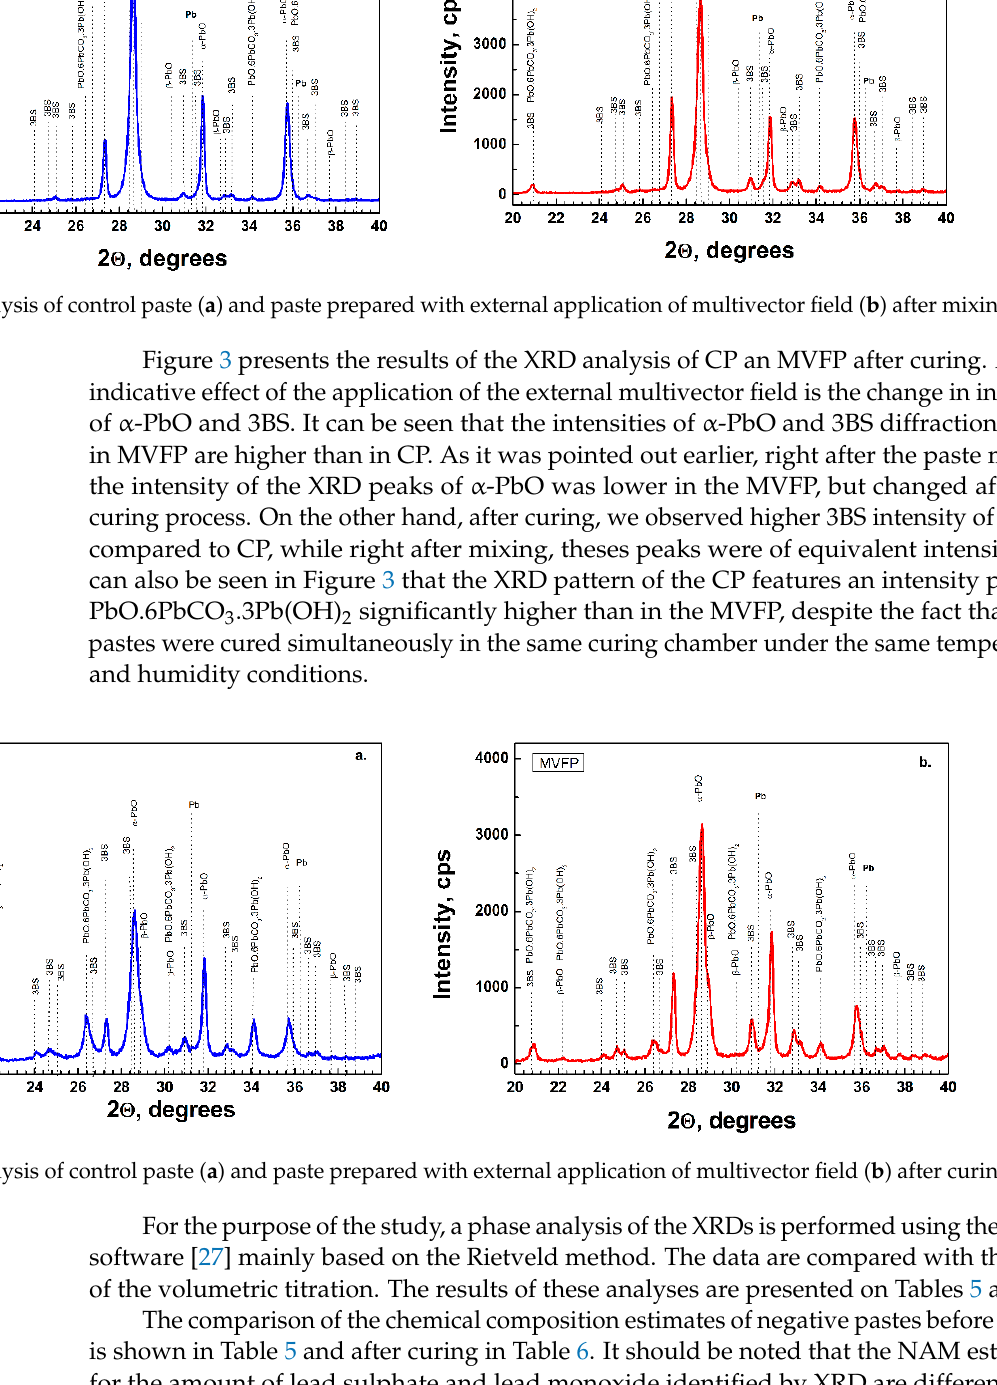
Table 5. Comparison of the chemical analysis by titration and XRD of the negative pastes before curing. By Chemical Analysis